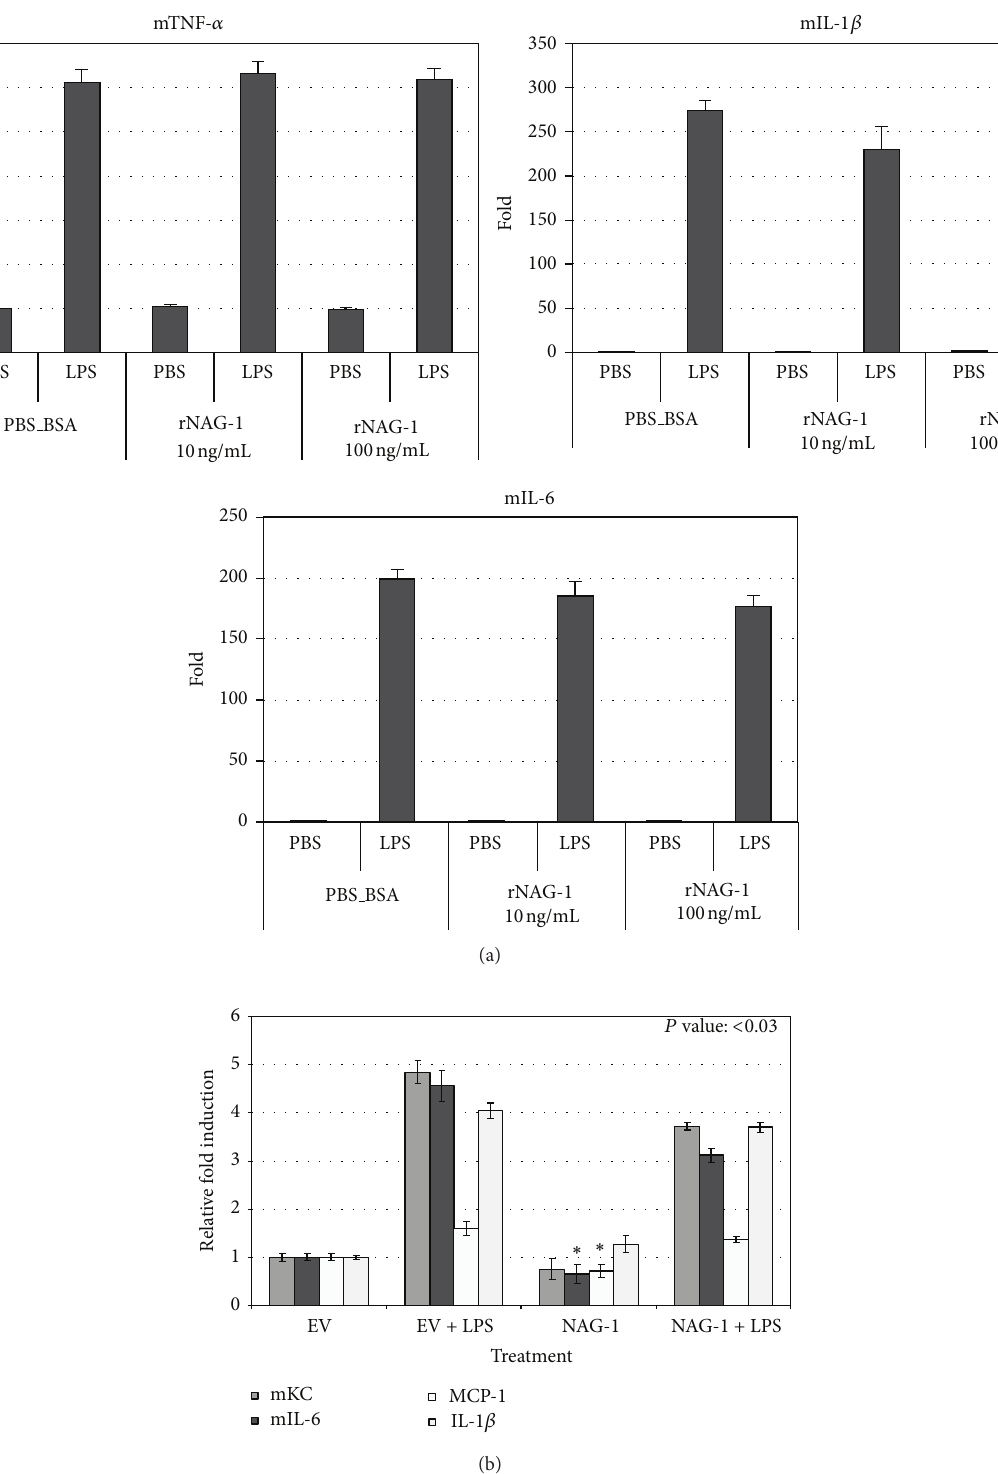
Figure 2: NAG-1 does not inhibit LPS-induced inflammatory cytokine formation in macrophages. (a) RAW 264.7 cells were plated in 60mm dishes. After 24 hr, cells were treated with NAG-1 protein (R&D) at the concentrations indicated for 5 hrs and then treated with LPS (5ng/mL) for 20hrs. RNA was isolated from the collected cells and used for real-time PCR analysis, using primers specific to the genes indicated. The data are expressed as fold increases compared to untreated cells. Error bars represent standard deviation. (b) RAW 264.7 cells were transfected with empty vector ( − ) or NAG-1 expression vector (+), and then the cells were treated with 1 𝜇 g/mL LPS for 6 hours. RNA was extracted and used for real-time PCR analysis, using primers specific to the genes indicated, using m 𝛽 -actin as a control gene. The data are expressed as fold increases compared to untreated cells. Error bars represent standard